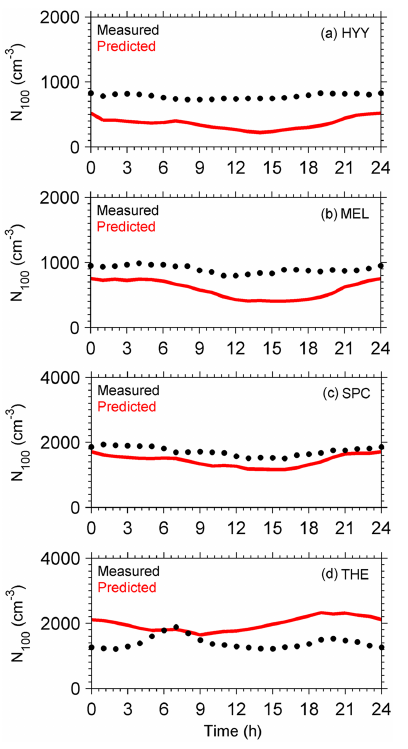
Figure 8. Average diurnal profiles of particle number concentra- tions (cm − 3 ) above 100nm in (a) Hyytiälä (Finland), (b) Melpitz (Germany), (c) San Pietro Capofiume (Italy), and (d) Thessaloniki (Greece) during 5 June–8 July 2012. Red lines correspond to pre- dictions and black symbols to observations.